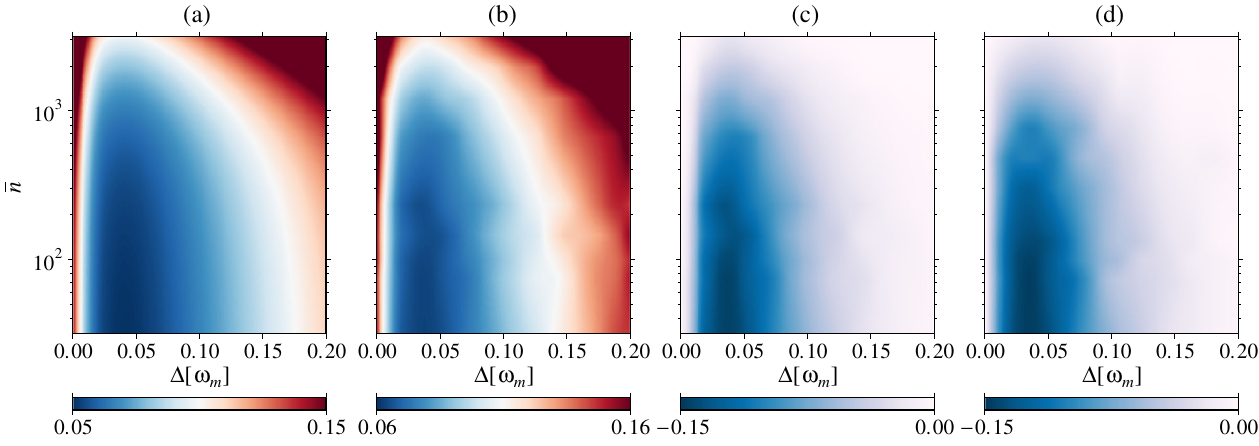
FIG. 5 (color online). (a),(b) The Fano factor F versus (bare) detuning Δ and bath occupation number ¯ n . Note that by varying ¯ n , we automatically vary the crucial quantity γ ¯ n appearing in Eqs. (50) and (51). (a) Plot of the simple analytical expression (50). (b) The numerical result obtained with Monte Carlo trajectories for 30 000 mechanical oscillations. (a) and (b) are in good agreement despite the fact that in the parameter regime considered here, some of the approximations are barely fulfilled. Note that the color scale in the numerical prediction for the Fano factor is slightly shifted up by 0.01, possibly hinting at some additional diffusion process not considered in the analytical model. (c) The prediction for Wigner-function negativity (defined as the quotient of the most negative and the most positive values of W ) obtained by extrapolating the results for F from (b) using the function from Fig. 6. (d) The Wigner- function negativity as directly extracted from the numerical result of the Wigner function. The constant parameters in all 2 κ ; γ 2 γ ; E Þ ¼ ð 0 . 05 ; 0 . 1 ; 10 − 7 ; 1 . 56 Þ × ω plots are ð g 0 ; κ . The approximate average number of photons in the cavity is 1.5 E ¼ E ¼ m in these